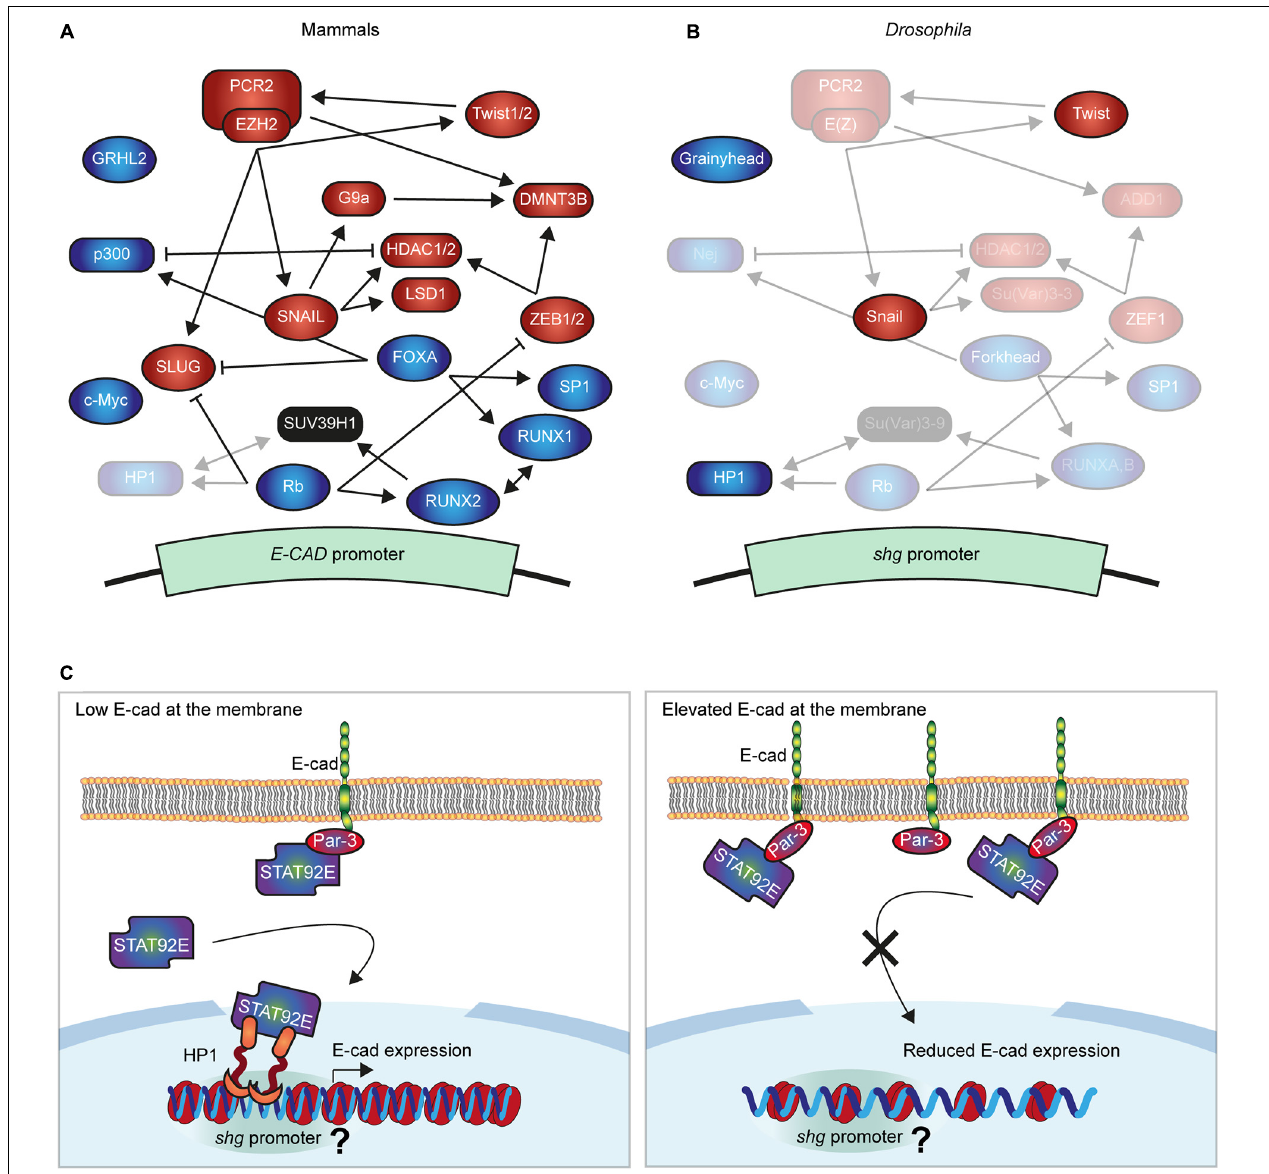
FIGURE 1 | Molecular mechanisms regulating E-cadherin gene expression. (A,B) Summary of the best known negative and positive regulators of E-cad in mammals (A) and Drosophila (B) . The expression of E-cad gene ( shotgun , shg , in Drosophila ) is controlled by transcription factors (ellipses), which inhibit (red) or promote it (green) and interact with the E-cad promoter with varying affinities. Several further proteins modify chromatin at the promoter (squircles) silencing the E-cad expression (red) or increasing it (green). These proteins cooperate, compete, and regulate each other, establishing the intricated network that fine-tune the expression of E-cad. In panel (B) the non-conserved proteins were removed while conserved maintained their relative positions but their names were replaced with those of the Drosophila orthologs. The regulatory roles of transparentized proteins in panels (A,B) were not demonstrated in the respective systems. (C) The proposed model of E-cad modulation of its expression. A subpool of STAT92E translocates into the nucleus independently of the canonical JAK/STAT signalling, where it interacts with heterochromatin protein 1 (HP1). Within euchromatin, HP1 localises at specific loci corresponding to gene promoters, including that of the shg gene. Concurrently, STAT92E is recruited to the cell surface by E-cad and its binding partner Par-3. Therefore, elevated levels of E-cad outcompete STAT92E from the nucleus inhibiting its function in heterochromatin formation and promoter regulation. As the result, elevated E-cad at the cell surface reduces shg